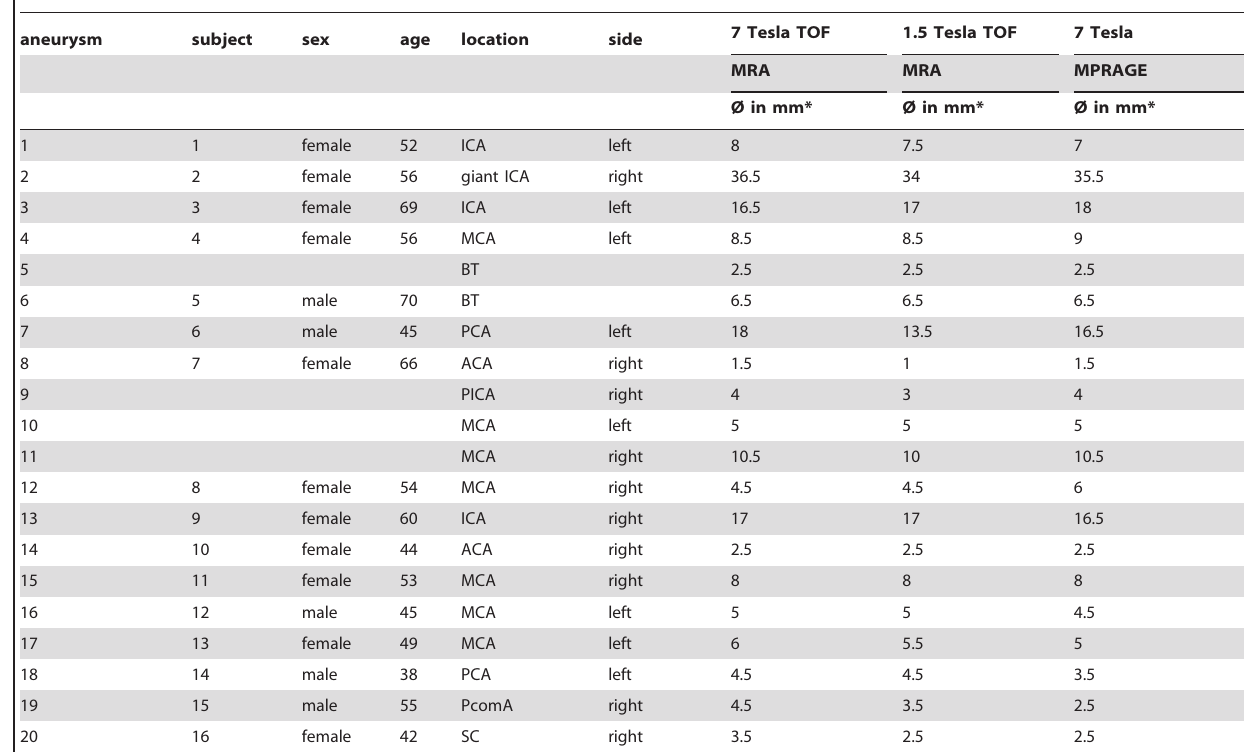
Table 1. Basic demographic data and aneurysm size and location.